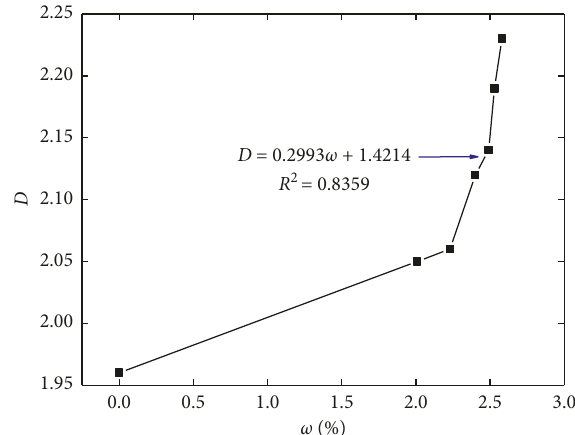
Figure 10: Relationship of fractal dimension D with moisture content ω